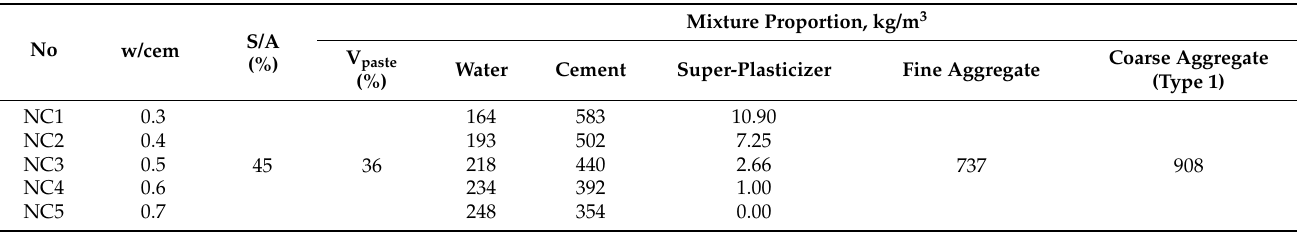
Table 1. Mixture proportions adopted to establish the reference relationship curve between UPV and the strength evolution